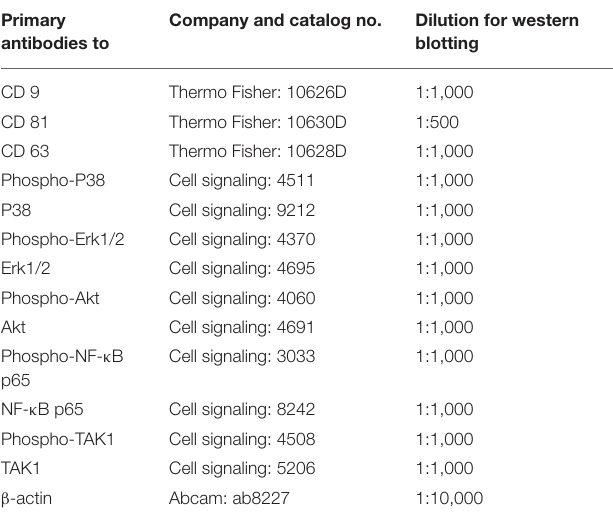
TABLE 2 | Primary antibodies for western blot. Primary Company and catalog antibodies to